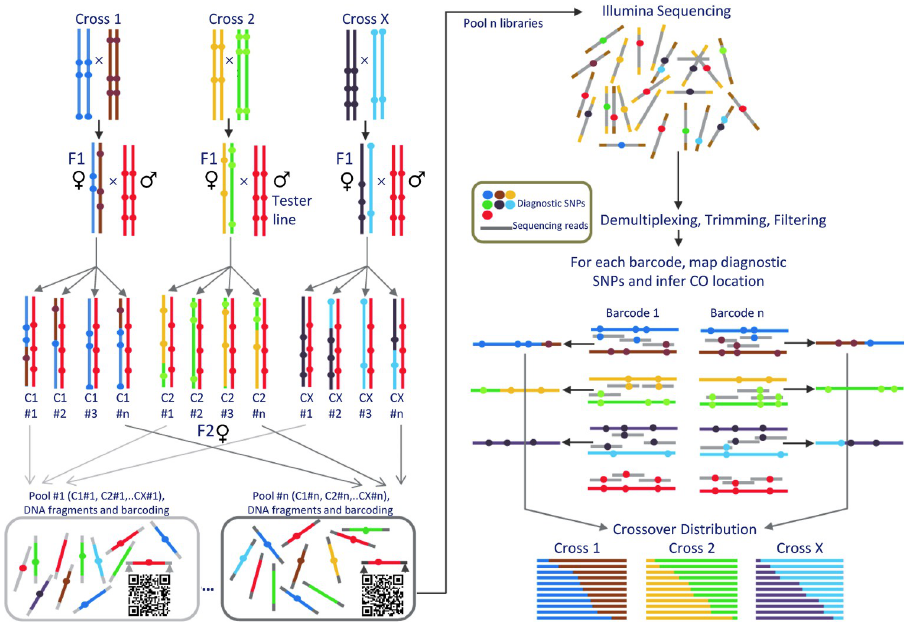
Fig 1. Dual-barcoding genotyping method used to obtain crossover rates. Diagnostic SNPs are used as genetic barcodes and allow the pooling of multiple F 2 individuals from different crosses for a given sequence barcode (left panel). The combination of genetic and sequence barcodes ensures efficient genotyping of multiple individuals and accurate crossover localization along chromosome arms (right panel). Diagnostic, or strain-specific SNPs, are singletons for the complete set of genotypes used in the study, including the tester line.